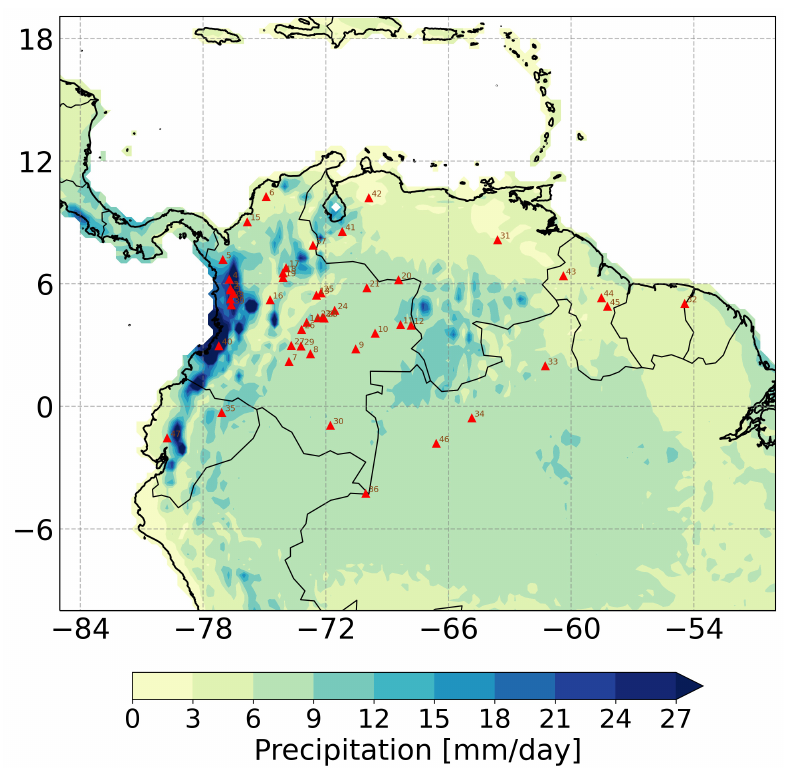
Figure 1. Location of the streamflow gauges from IDEAM, SO-HYBAM, and GRDC; the contours show the long-term daily precipitation over the study region for the period 1981–2019.